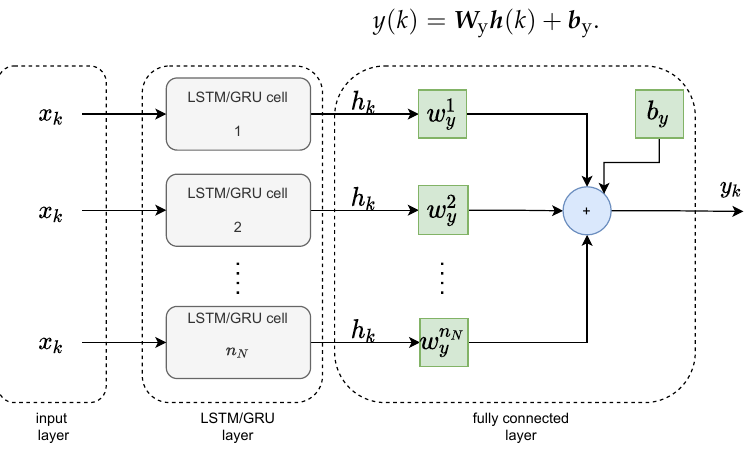
Figure 2. The topology of the LSTM and GRU